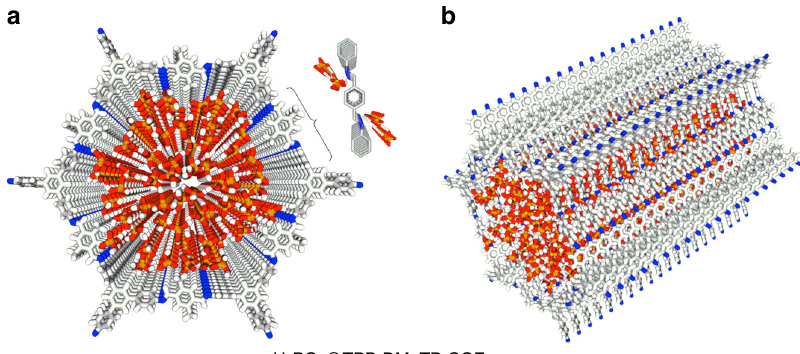
Fig. 3 Con fi ning proton network in nanochannel. a Reconstructed crystal structure of H 3 PO 4 @TPB-DMeTP-COF (top view) with the H 3 PO 4 network locked in the 1D channel (each macrocycle of one layer contains 57 H 3 PO 4 molecules; only 20 layers are shown; grey, C; blue, N; white, H; red, O; orange, P). Inset, the N in ⋯ H – O hydrogen-bonding interactions between channel walls and H 3 PO 4 network. b Reconstructed crystal structure of H 3 PO 4 @TPB- DMeTP-COF (side